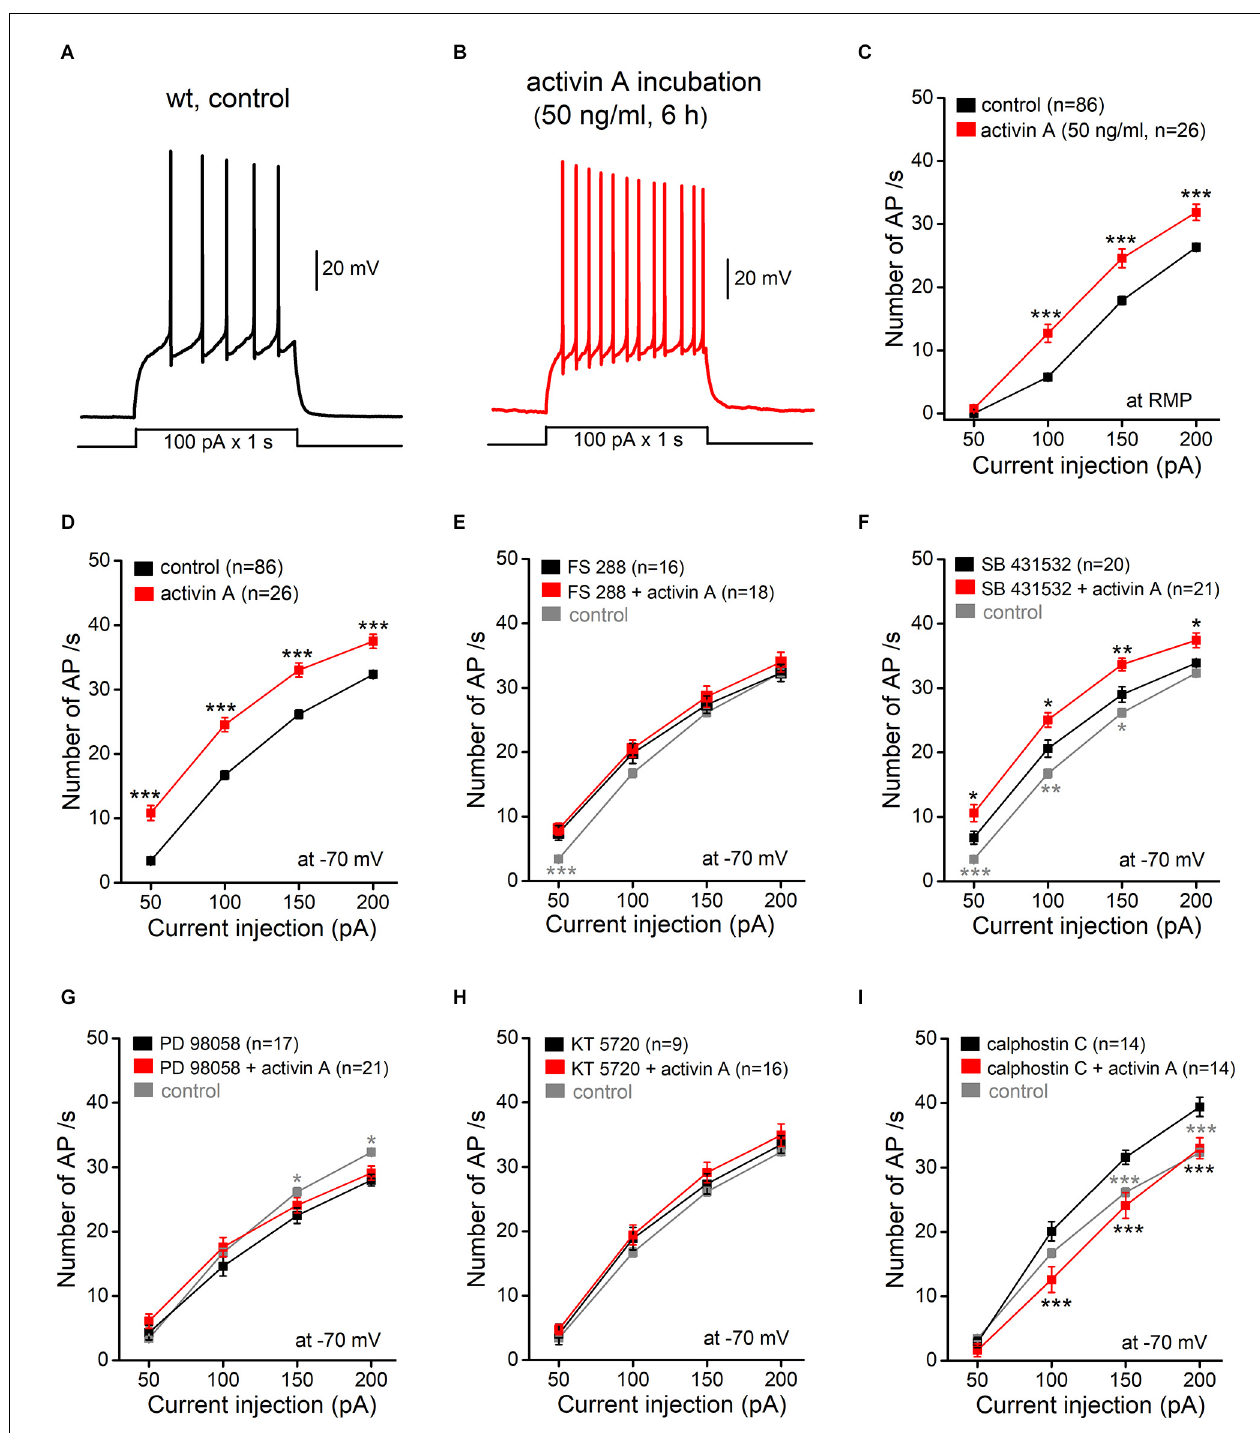
FIGURE 2 | Excitatory effect of activin A pre-incubation involves non-canonical (non-SMAD) signaling. (A,B) Representative current-clamp recordings from a wt control slice (A) and from a wt slice pretreated with recombinant activin A (50 ng/ml for 6 h; B ) at RMP. (C,D) Plots summarize the excitatory effect of activin A (4–10 h) on granule cell firing upon depolarizing steps (for 1 s) at RMP (C) and at -70 mV (D) . (E–I) Follistatin 288 (FS 288, 160 ng/ml; E ) and SB 431532 (10 µ M; F ) were used to prevent activin receptor binding and to inhibit SMAD phosphorylation, respectively. PD 98058 (20 µ M; G ), KT 5720 (200 nM; H ), and calphostin C (100 nM; I ) were used to inhibit ERK-MAPK, PKA, and PKC, respectively. For these experiments, slices were either incubated with individual inhibitors for several hours or pre-incubated with inhibitors for 30 min before adding activin A (50 ng/ml, 4–10 h). Data from wt controls (in gray) were replicated in (E–I) to show the effects of the drugs on cell firing. * p < 0.05, ** p < 0.01, *** p < 0.001, compared to the respective black points.